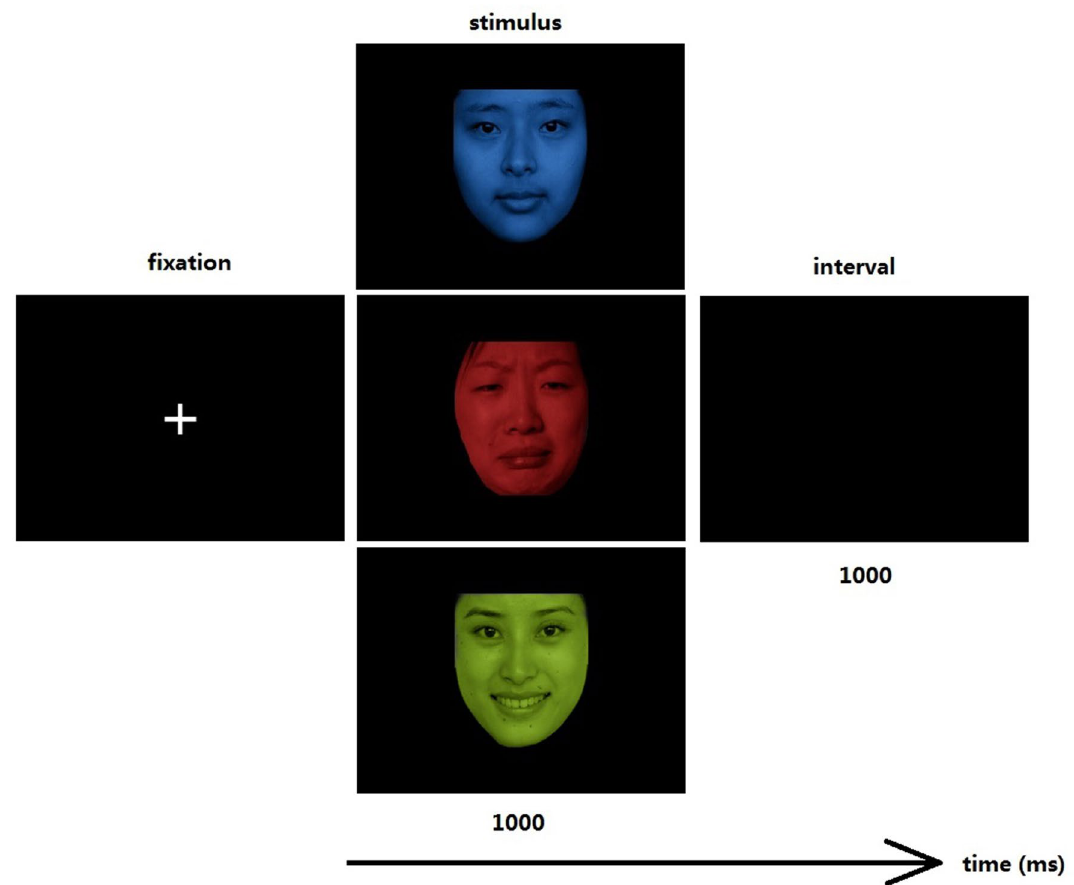
Figure 1. Illustration of one trial in this study. Participants watched 1000 ms of stimulus in the form of neutral, sad or happy face, separated by an inter-stimulus interval of 1000